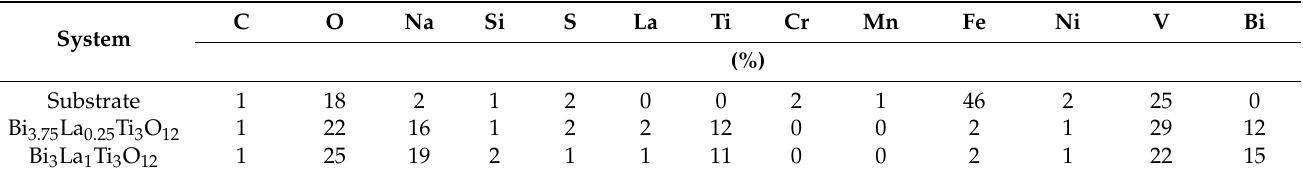
Table 8. Chemical analysis for Bi 3.75 La 0.25 Ti 3 O 12 and Bi 3 La 1 Ti 3 O 12 coatings and the substrate at a temperature of 1000 ◦